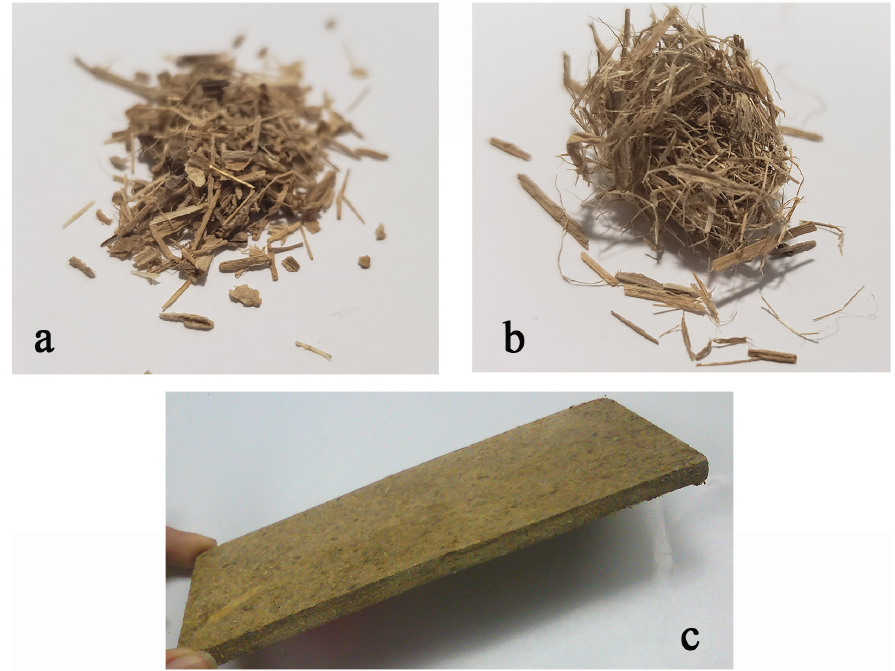
Figure 1 - Pictures of fine fiber (a) , coarse fiber (b) and particle board made of banana pseudo- stem (c)